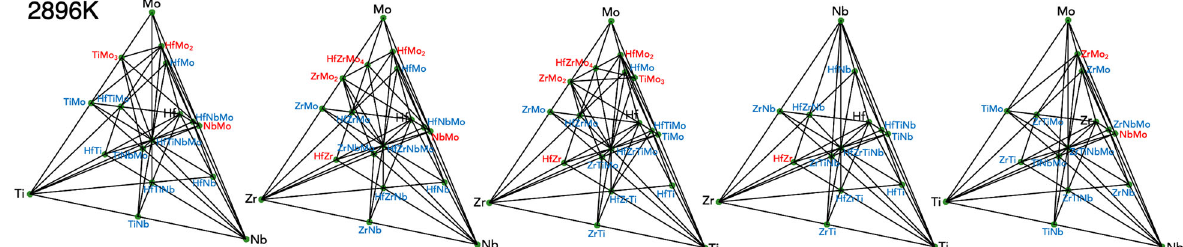
Fig. 3 Phase diagram of the Hf − Mo − Nb − Ti − Zr system. A series of quaternary phase diagrams representing the Hf − Mo − Nb − Ti − Zr system. Stable phases are indicated by green points on the tetrahedra. Intermetallic phases are labeled in red text while solid solution phases are labeled in blue. The diagrams are constructed at 2896 K, the melting temperature of pure